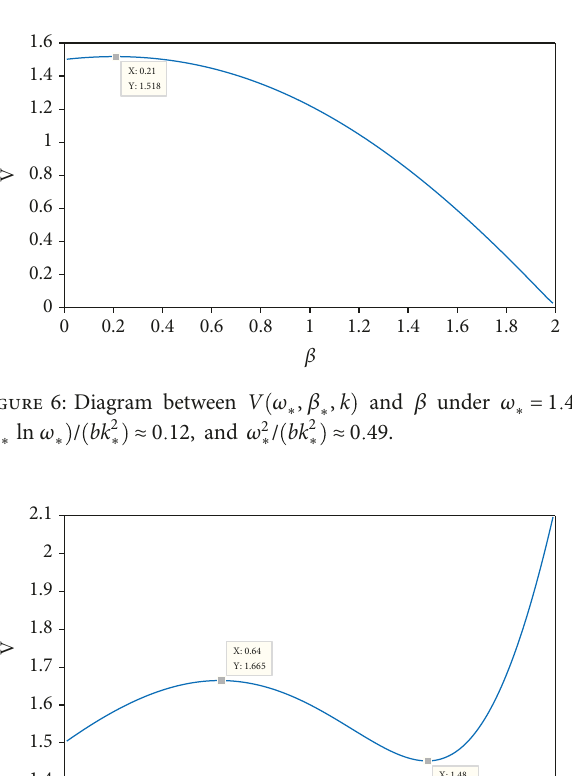
β β under ω ∗ , ∗ , k and